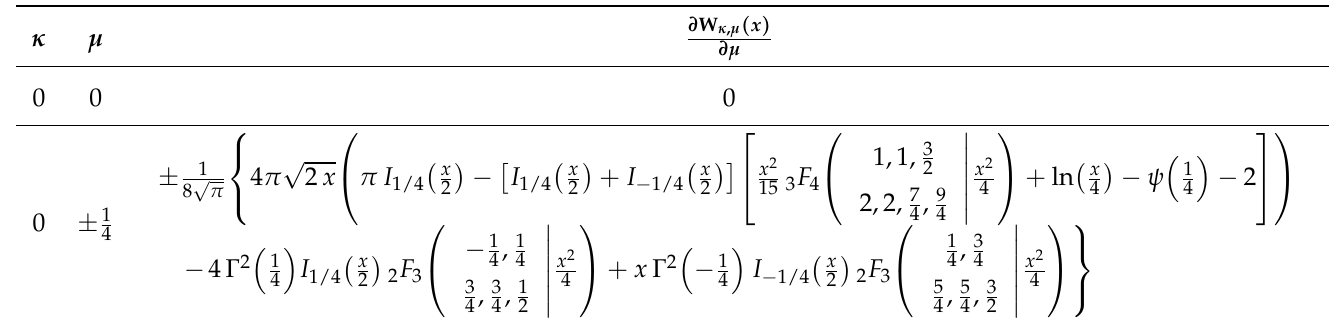
Table 4. Derivative of W κ , µ with respect to µ , by using